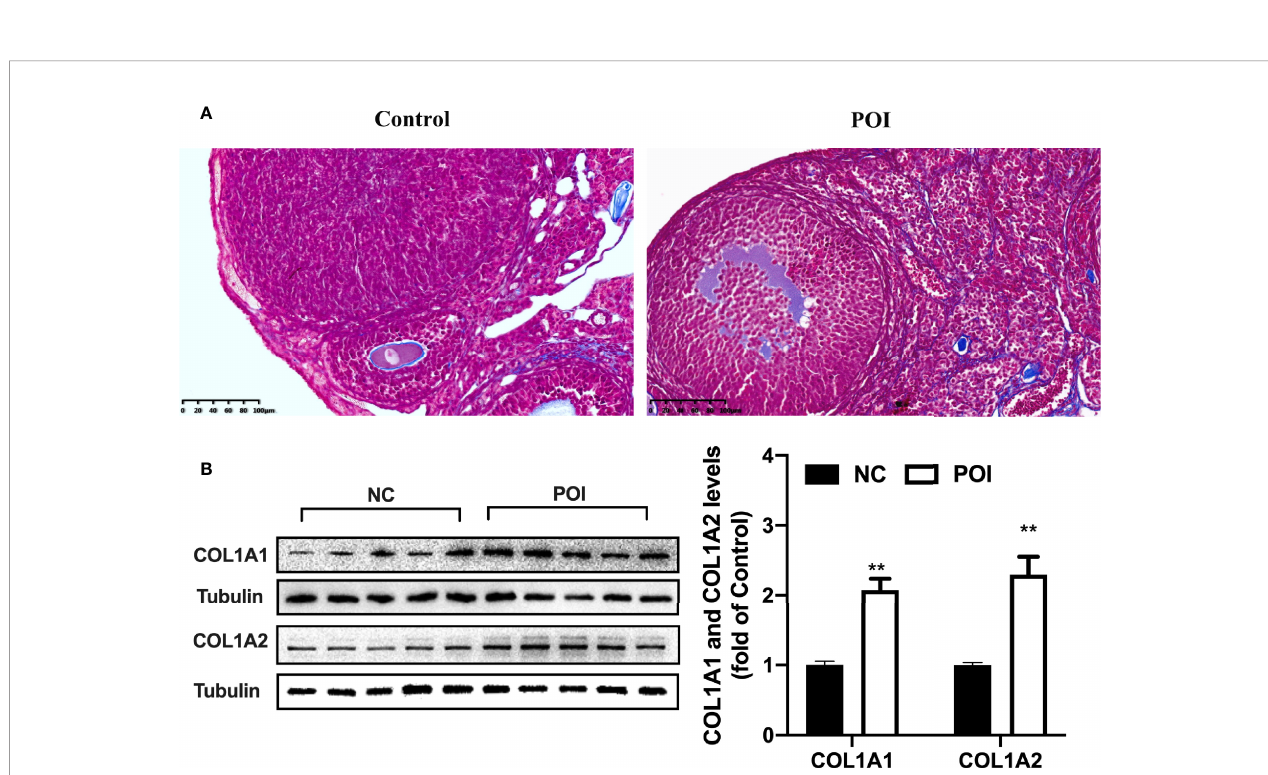
FIGURE 5 | Change of collagen I in the ovaries of POI mice. (A) The distribution of blue-staining collagen in the ovaries from control mice and POI mice by Masson staining. (B) COL1A1 and COL1A2 protein levels in the ovaries from two groups. n=5. ** P < 0.01 vs.